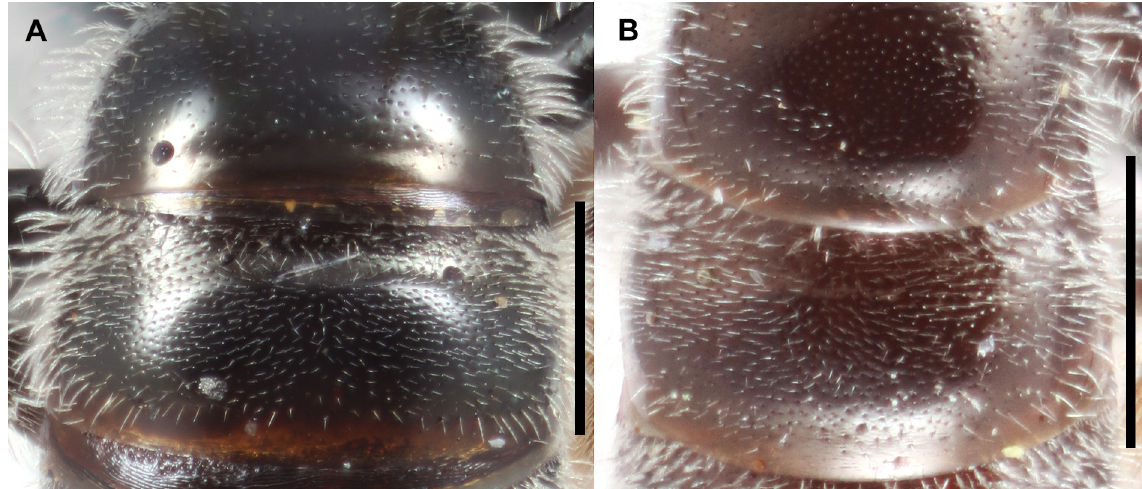
Fig. 109. T1–T2. A . Lasioglossum tegulariforme (Crawford, 1907), ♂, T1 more sparsely punctate than T2 and apical rims impunctate. B . L. helianthi (Cockerell, 1916), ♂, T1 and T2 uniformly punctate with some punctures on apical rims. Scale bars = 0.5